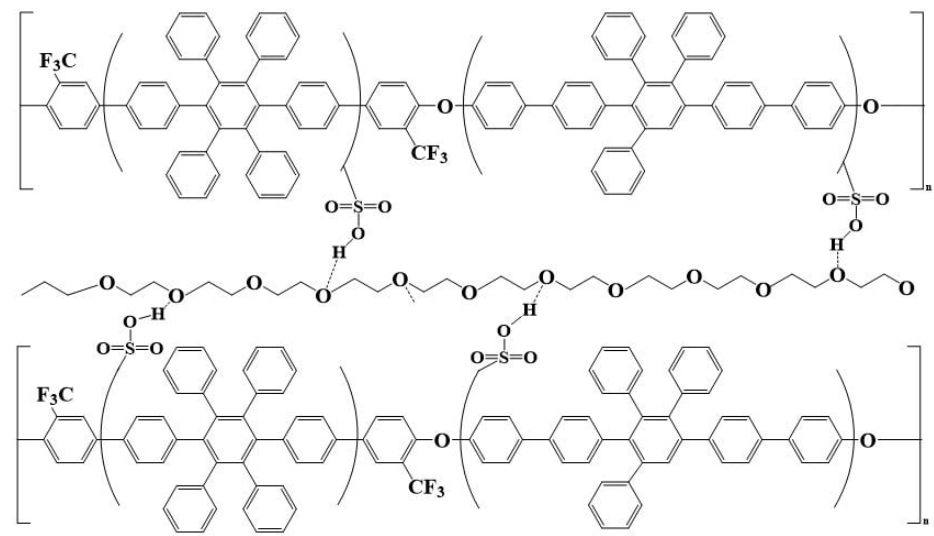
Figure 2. Schematic of physical crosslinking of sulfonated polymers.